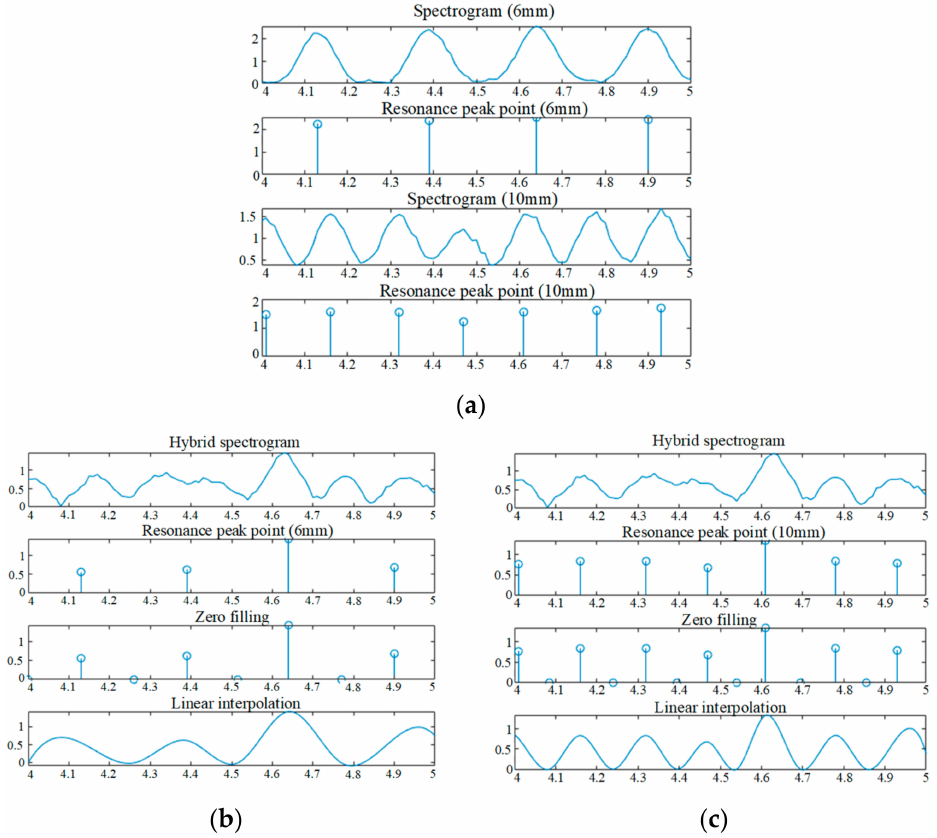
Figure 16. Diagram of the signal separation process. ( a ). Mixed spectrum diagram. ( b ) Separation results of small thickness data. ( c ) Separation results of large thickness data.